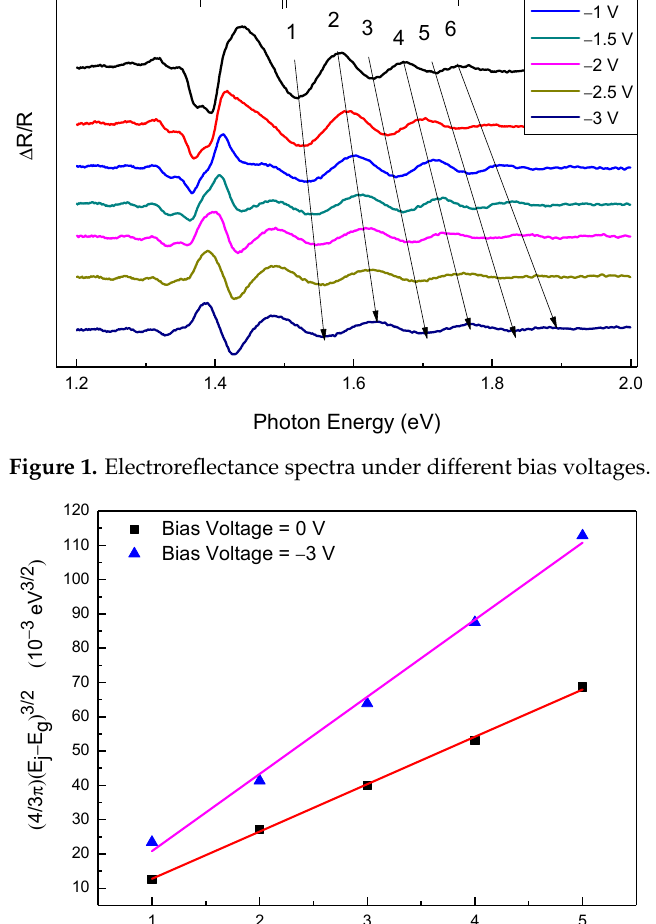
Figure 1. Electroreflectance spectra under different bias voltages.